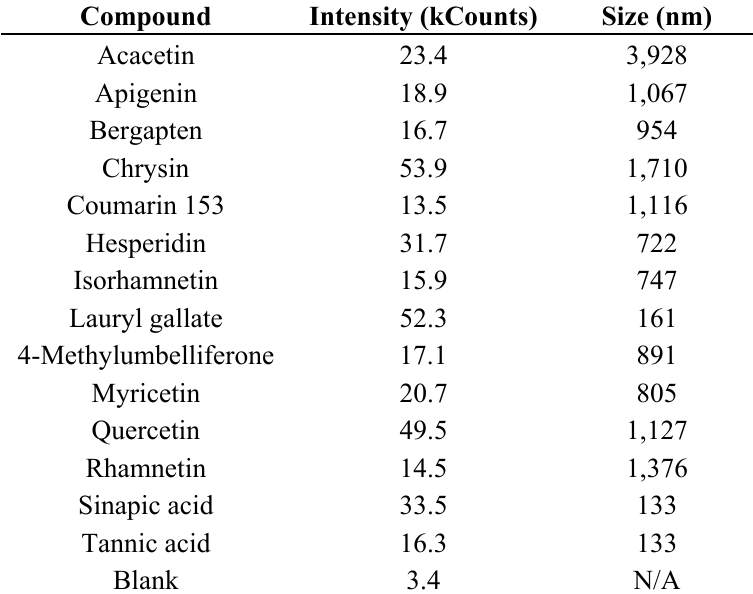
Table 1. Scattering intensities and average particle sizes of samples with significant DLS signals in